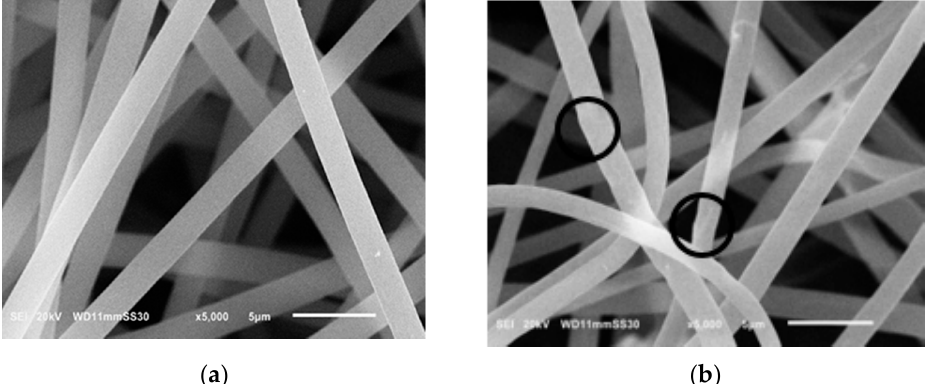
Table 2. Characteristic properties of the pristine and composite membranes.